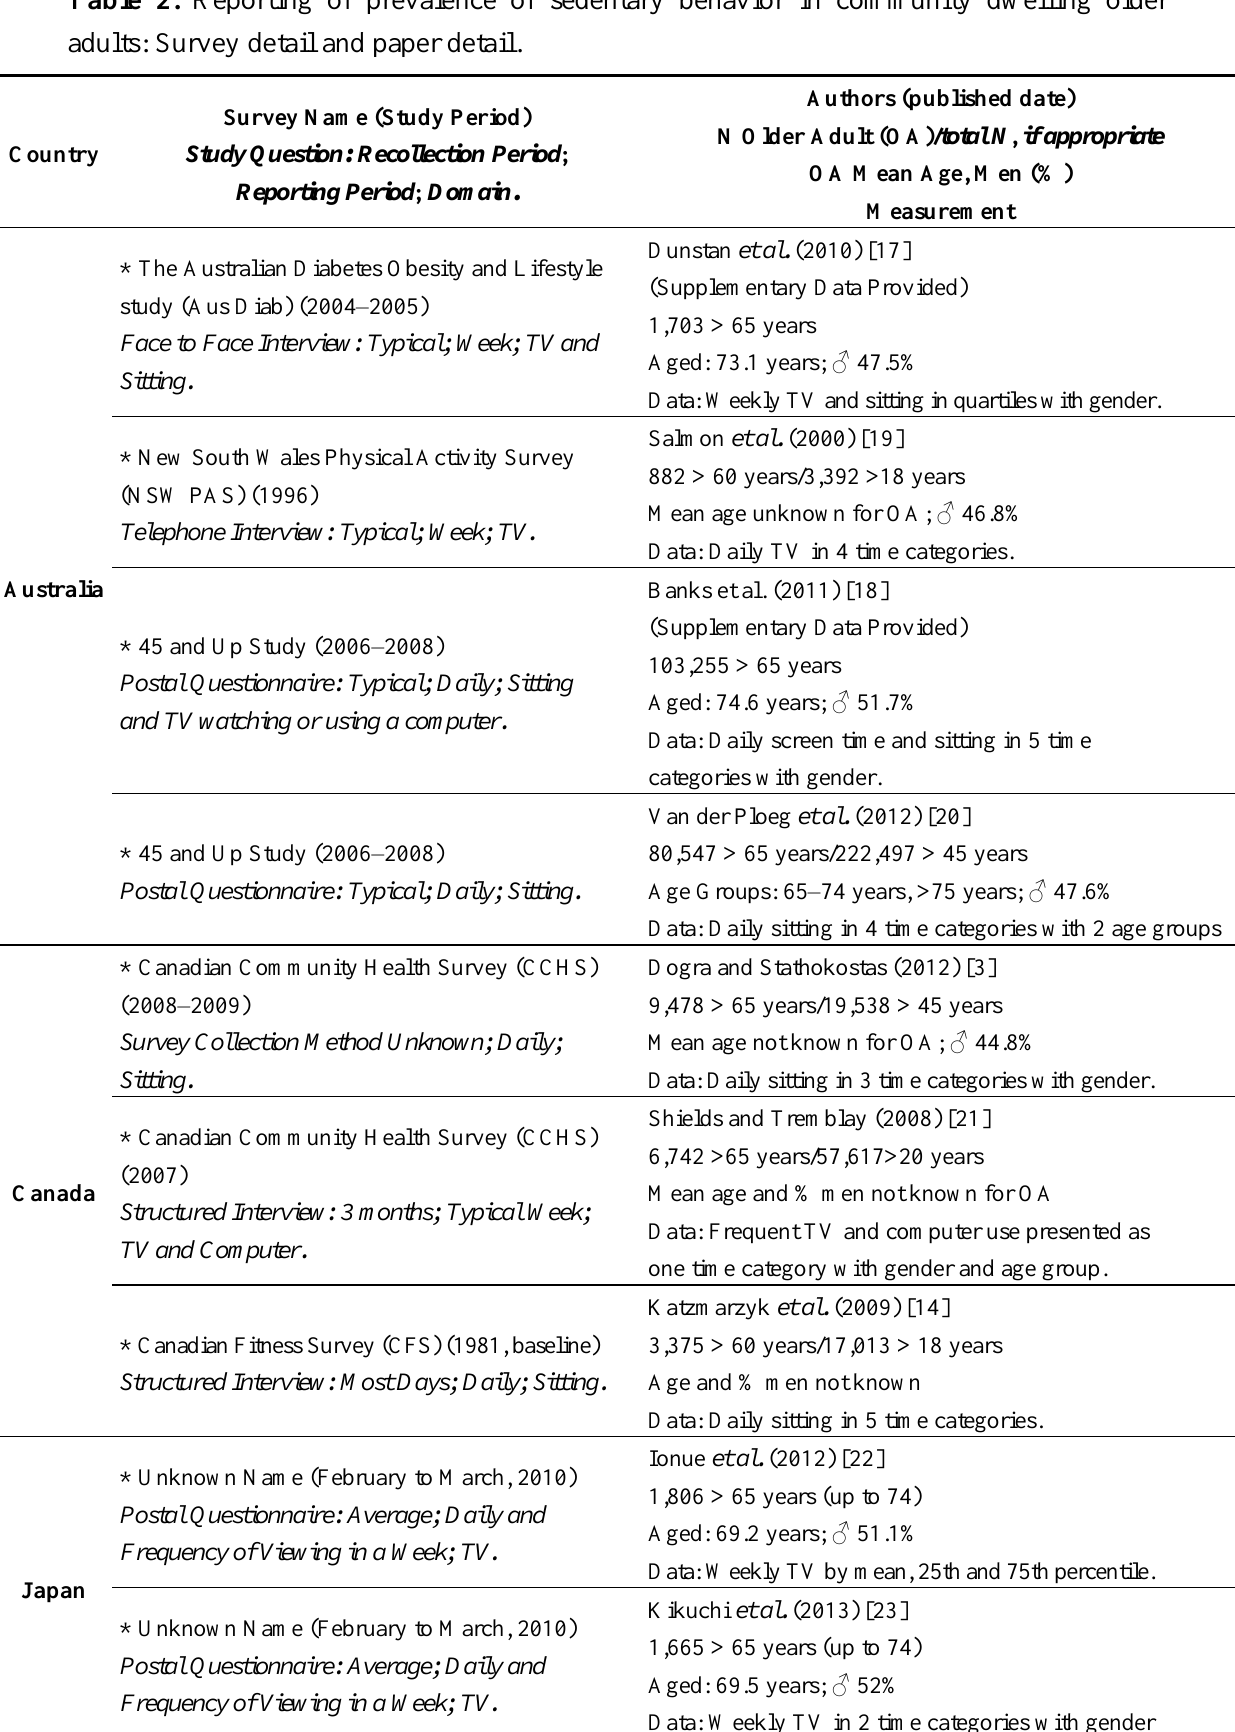
Table 2. Reporting of prevalence of sedentary behavior in community dwelling older adults: Survey detail and paper